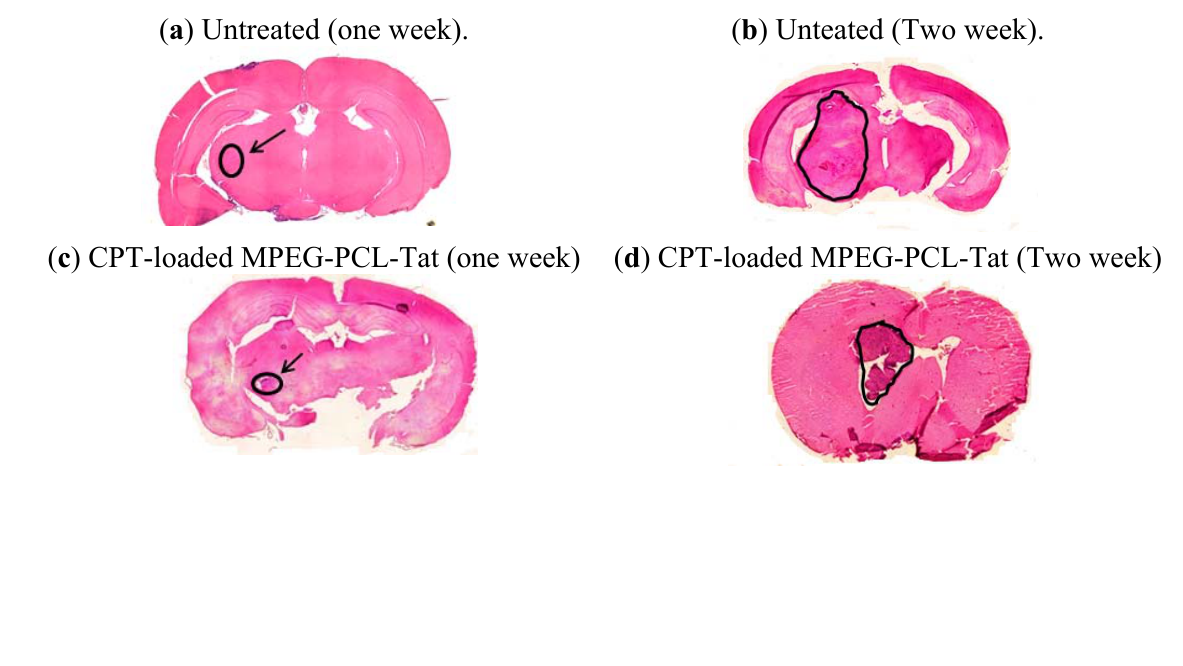
( c ) CPT-loaded MPEG-PCL-Tat (one week) ( d ) CPT-loaded MPEG-PCL-Tat (Two